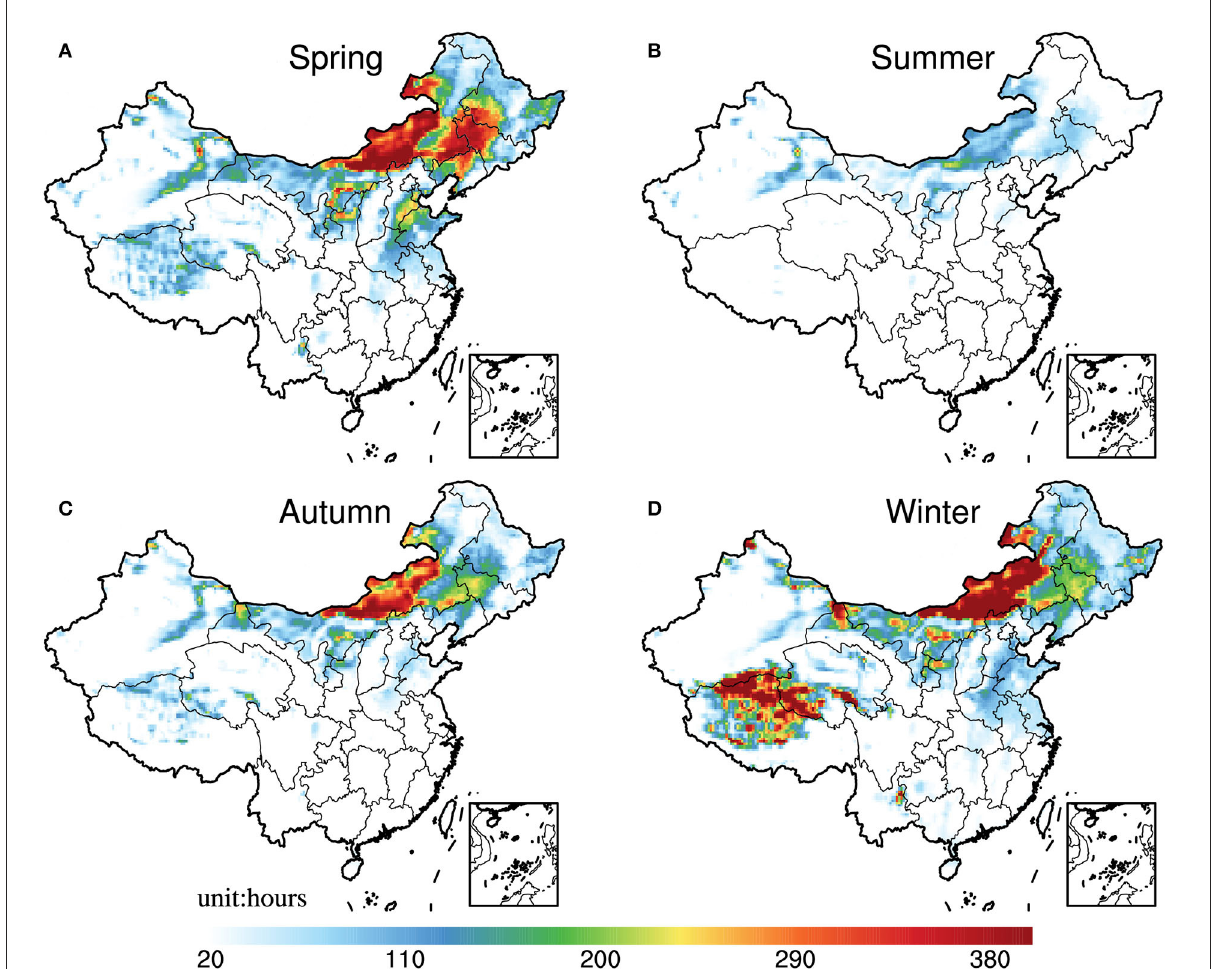
FIGURE2 The spatial distribution of the (A) spring, (B) summer, (C) autumn, and (D) winter mean number of hours with LLWS by using the hourly data from the ERA5 during